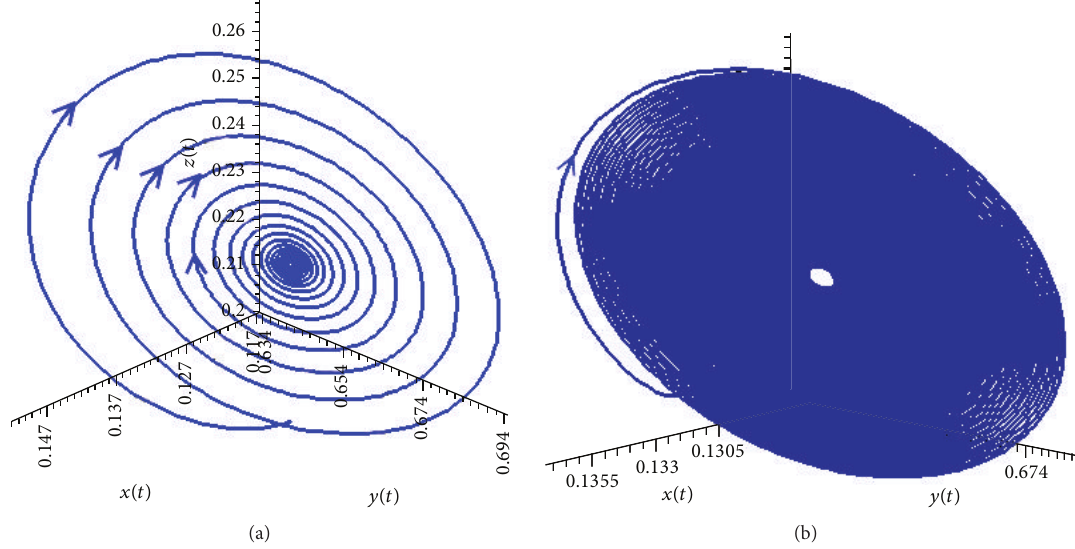
Figure 1: Phase portrait of system (1) near the equilibrium point 𝐺 , with initial conditions: (0.1325, 0.66, 0.19) . (a) 𝐺 is a stable focus for 𝑎 = 0.6 . Integration time: [0, 300] . (b) 𝐺 is a weakly stable focus for 𝑎 = 0.71 . Integration time: [0,3000] .